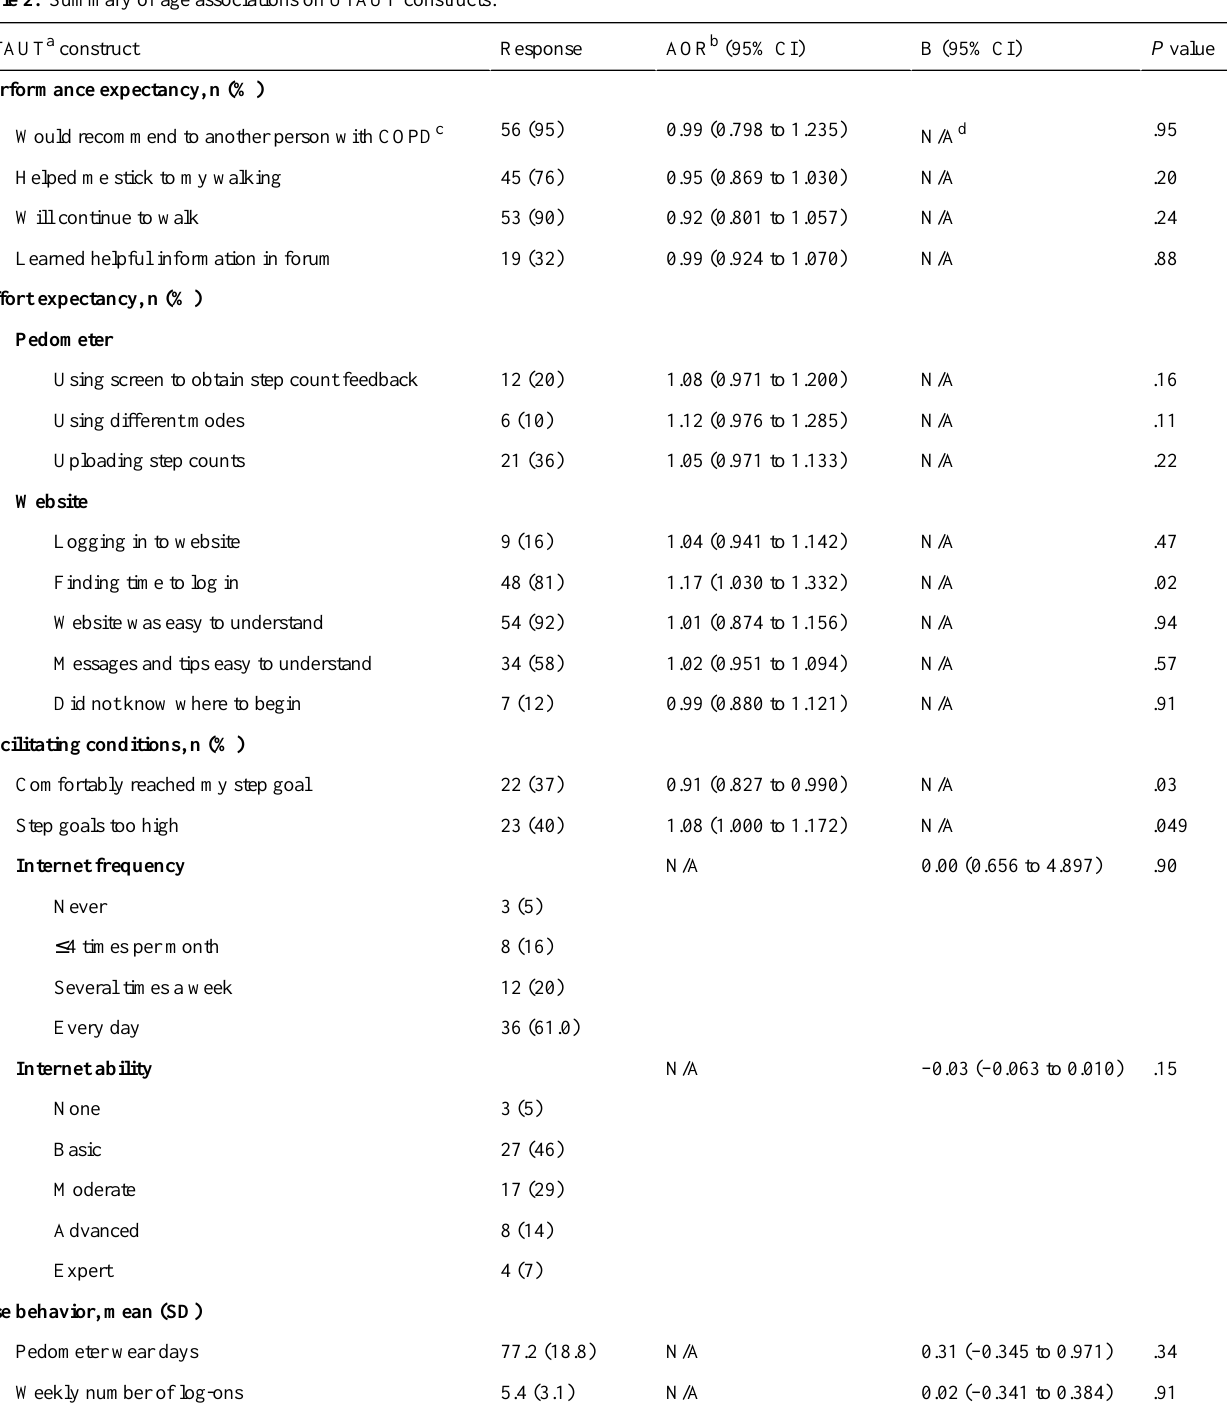
Table 2. Summary of age associations on UTAUT